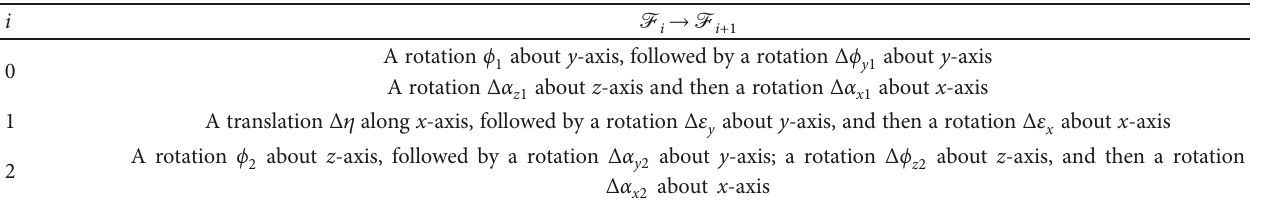
Figure 7: An illustration of the coordinate Table 3: Rotational and translational motion relations between adjacent coordinate systems.